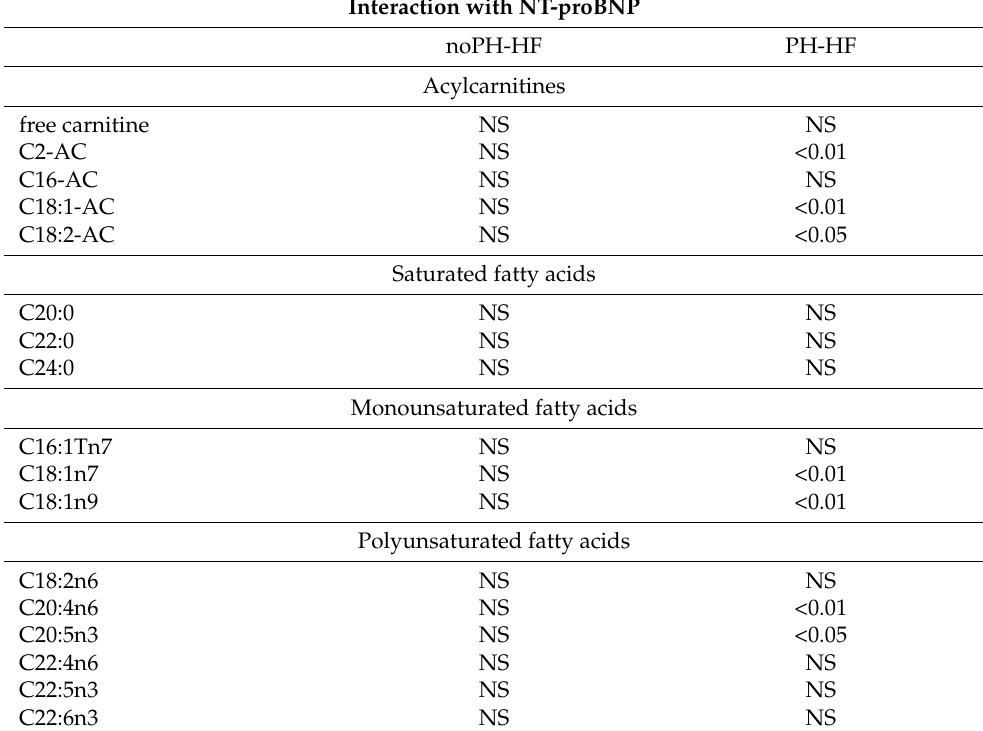
Table 4. Interaction analysis with